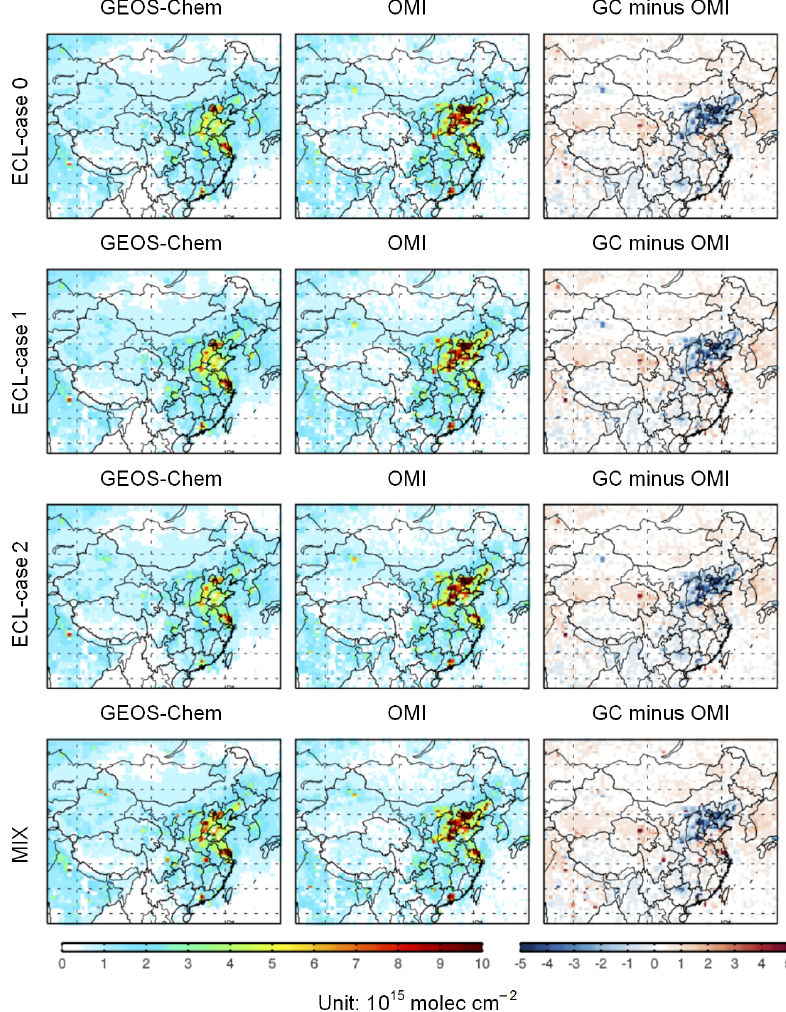
Figure 7. NO 2 tropospheric columns simulated by GEOS-Chem in sensitivity cases. For each case, the specific NO 2 vertical profiles were applied in inversion; summer average (June–July–August) in 2010.